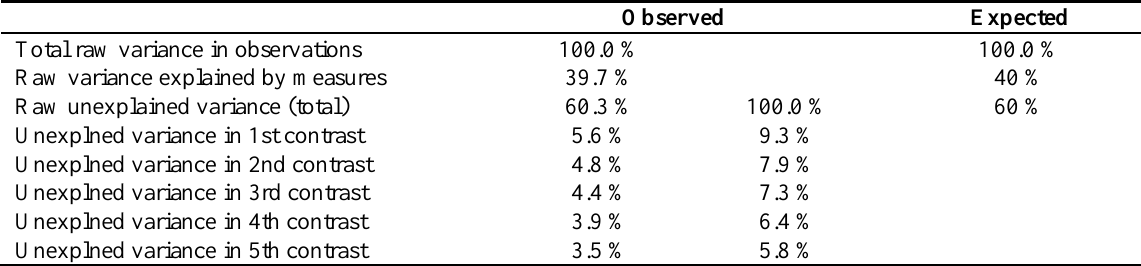
Table 2 . Standardized Residual